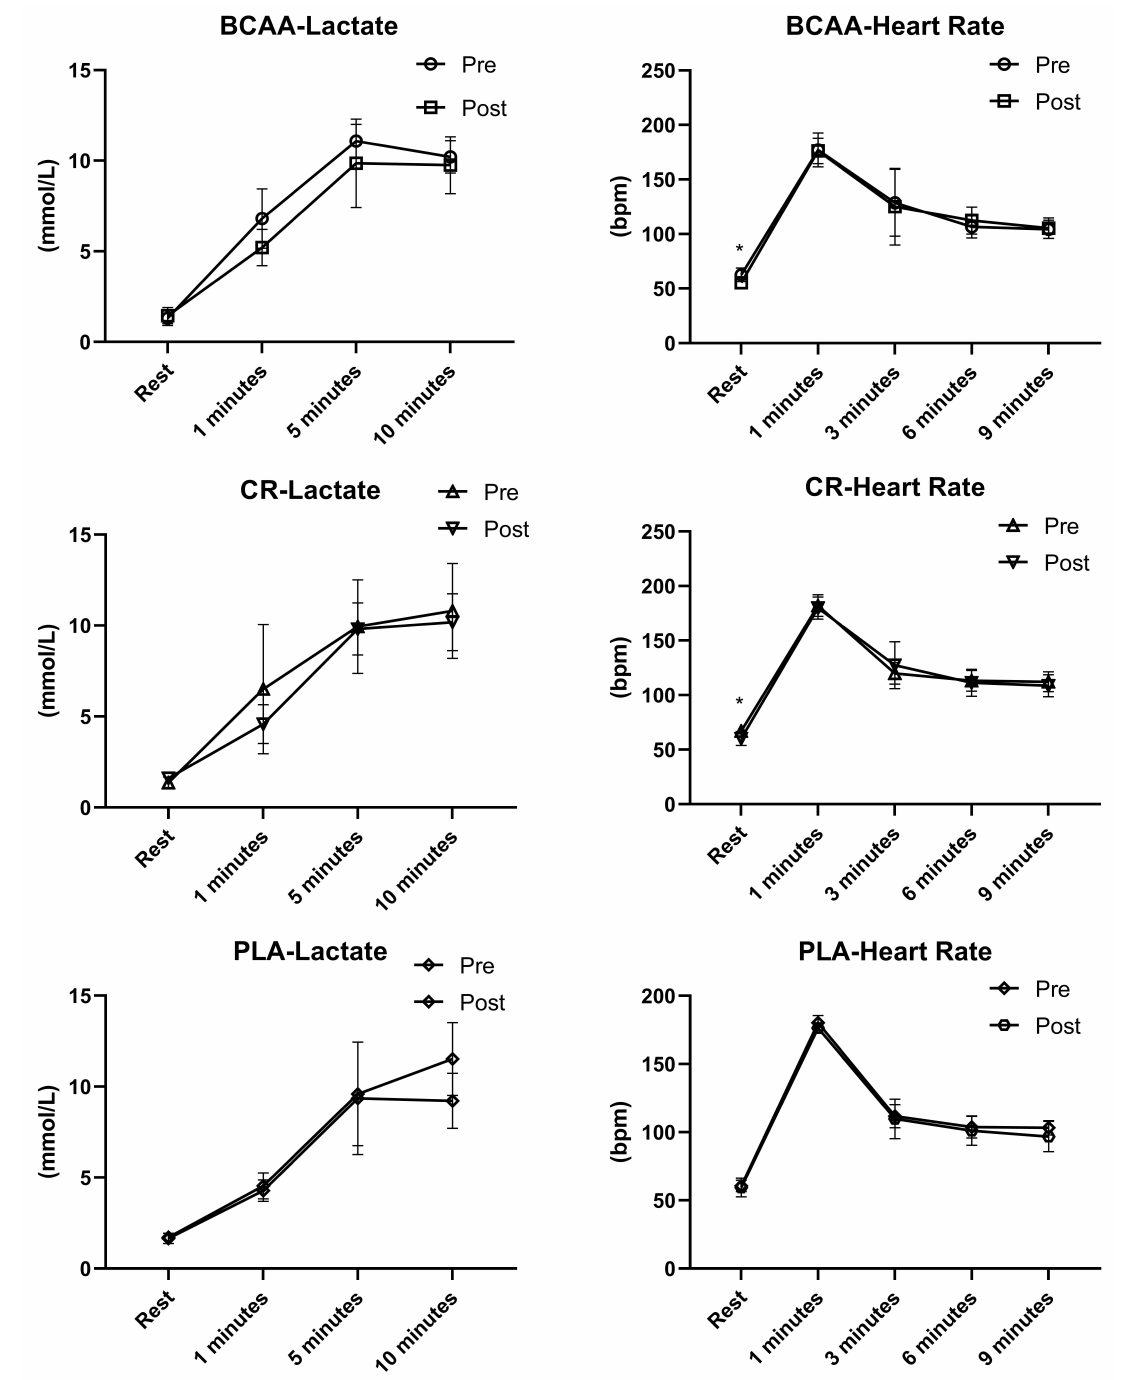
Fig. 1. The heart rate and lactate levels at different time points in rest and after exercise during recovery periods . BCAA, branched- chain amino acids group; CR, creatine group; PLA, placebo group; Pre, pre-supplementation period; Post, post-supplementation period. Values are mean ± SD. *Significant ( p < 0.05) difference compared with pre-and post-supplementation